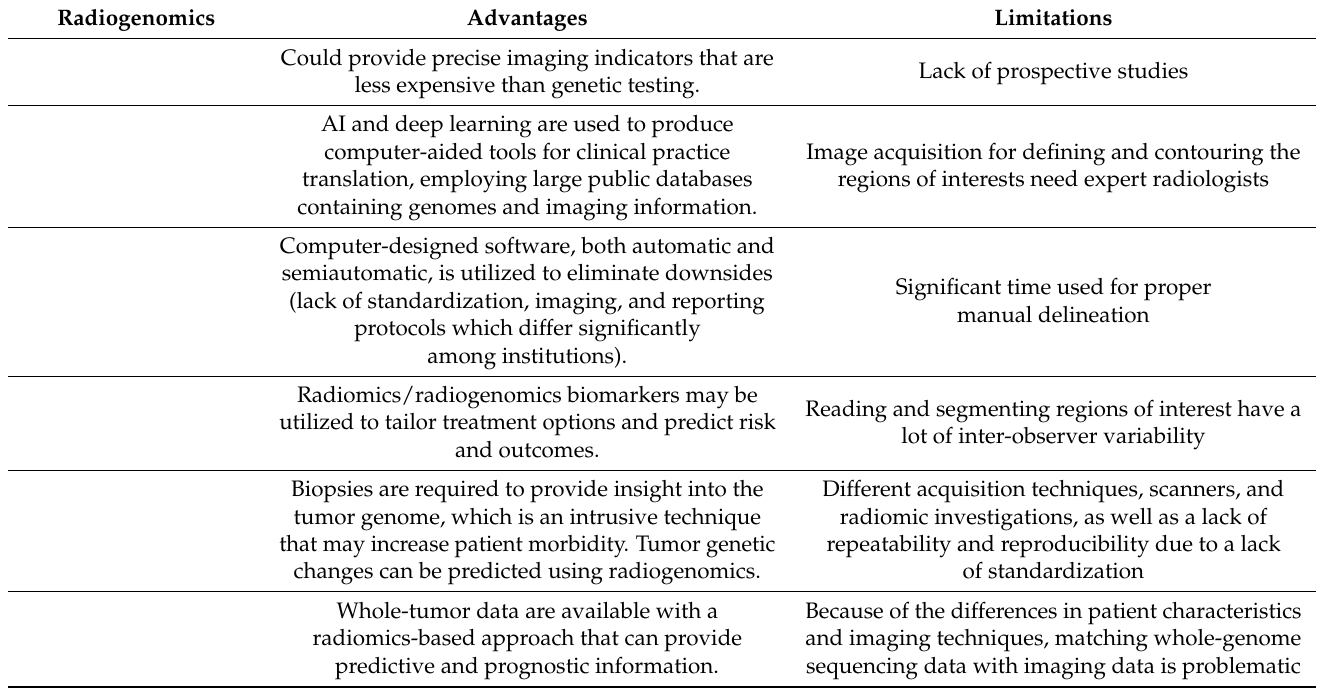
Table 1. Benefits and drawbacks of radiogenomics as compared with actual prostate cancer peril stratification management